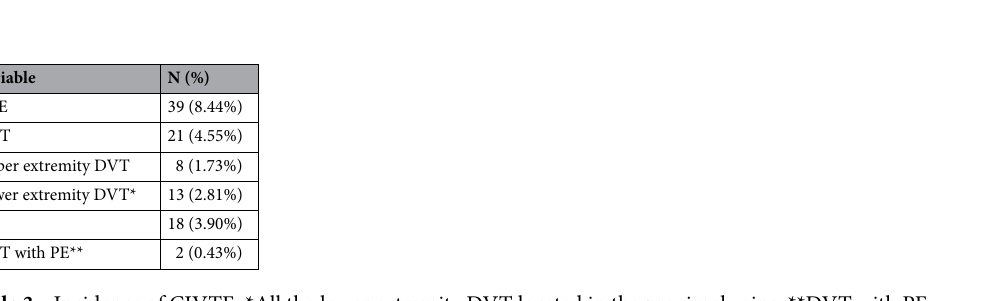
Table 3. Incidence of CIVTE. *All the lower extremity DVT located in the proximal veins. **DVT with PE was included in PE.